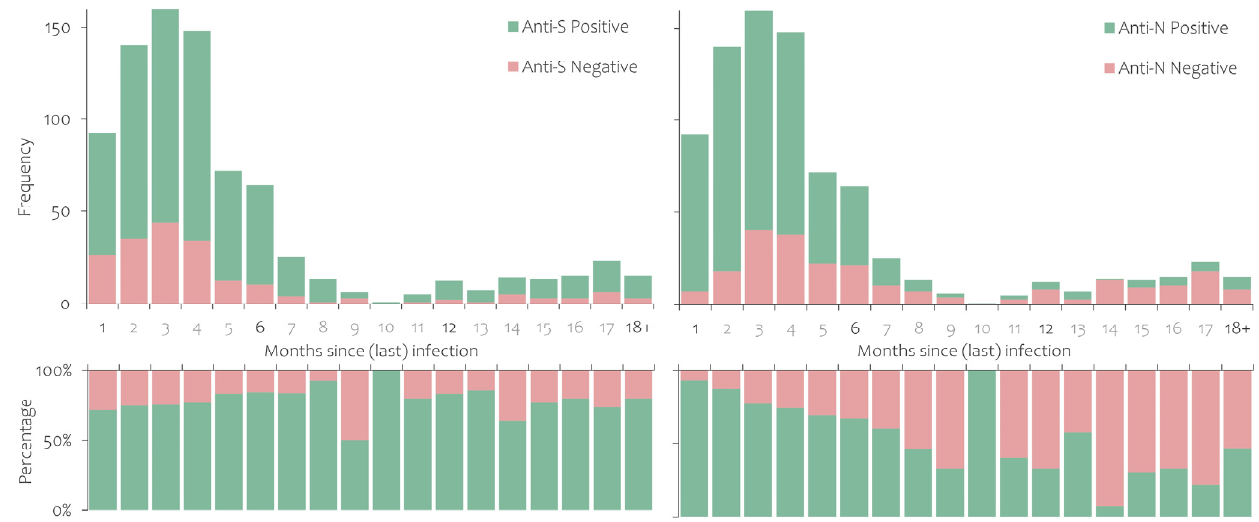
Figure 2. Anti-S and anti-N antibody persistence in study participants who were notified as infected with SARS-CoV-2 but had never been vaccinated with a COVID-19 vaccine.